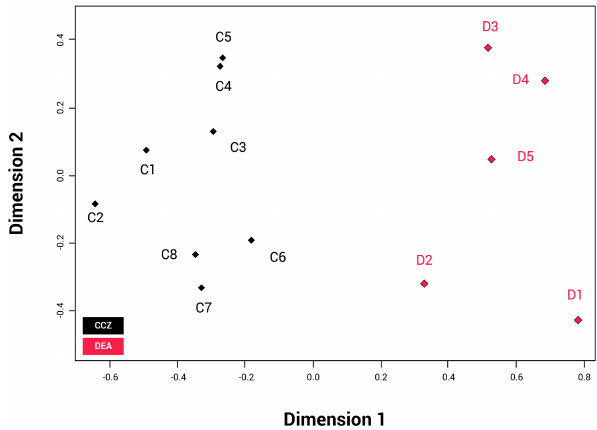
Figure 6. NMDS plot showing the beta biodiversity (dissimilarities or similarities) for each of the 13 amphipod trap sampling stations associated with the two basins, Clarion–Clipperton fracture zone (CCZ) (black) and the DisCOL experimental area (DEA) (red). Data are supported by a low stress value of